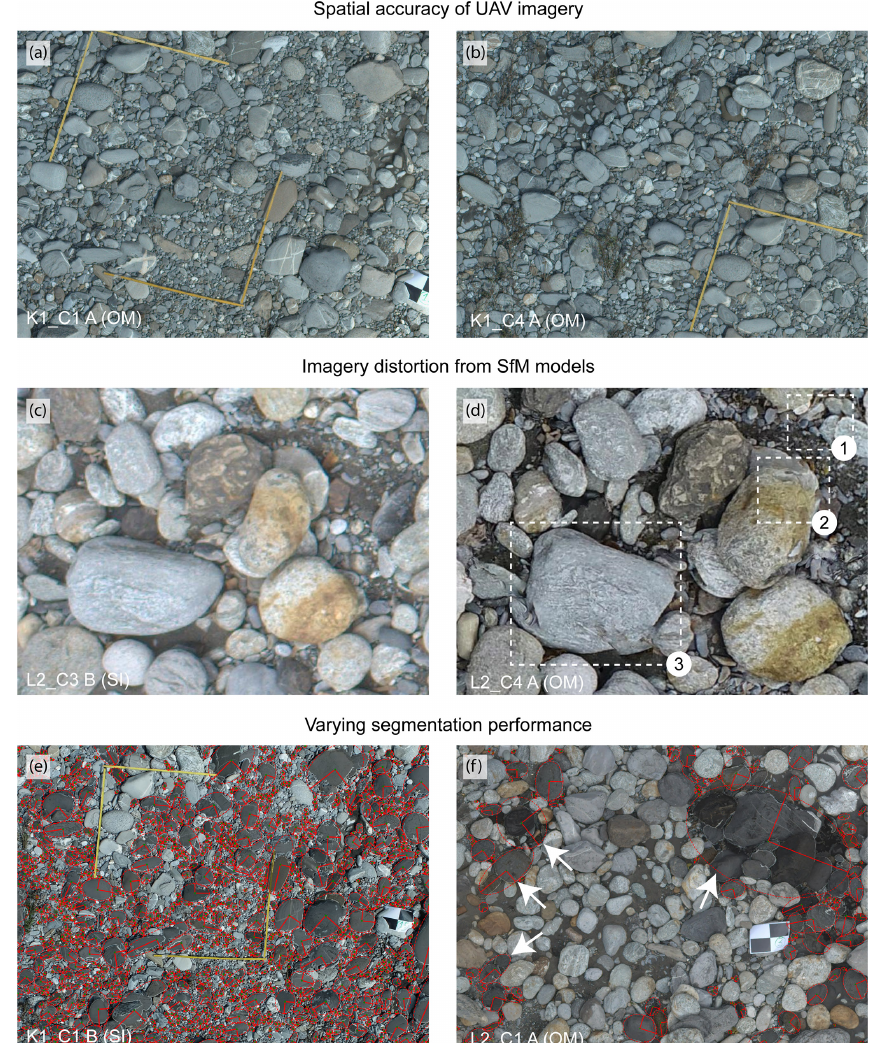
Figure 10. Systematic factors that influence grain size estimation from UAV imagery, especially from orthophoto mosaics (OM). (a, b) Effect of varying accuracy of SfM (structure from motion) used for referencing for orthophoto mosaics, which should display the same extent. (c, d) Comparison of undistorted single, nadir images (SI) with orthophoto mosaics, which highlight small-scale image warping and artifacts: (1) duplication from incorrect image stitching, (2) blurring of pebble boundaries, and (3) irregular grain shapes. (e, f) Selected results highlighting the varying image segmentation performance. Examples of systematic under-segmentation marked with white